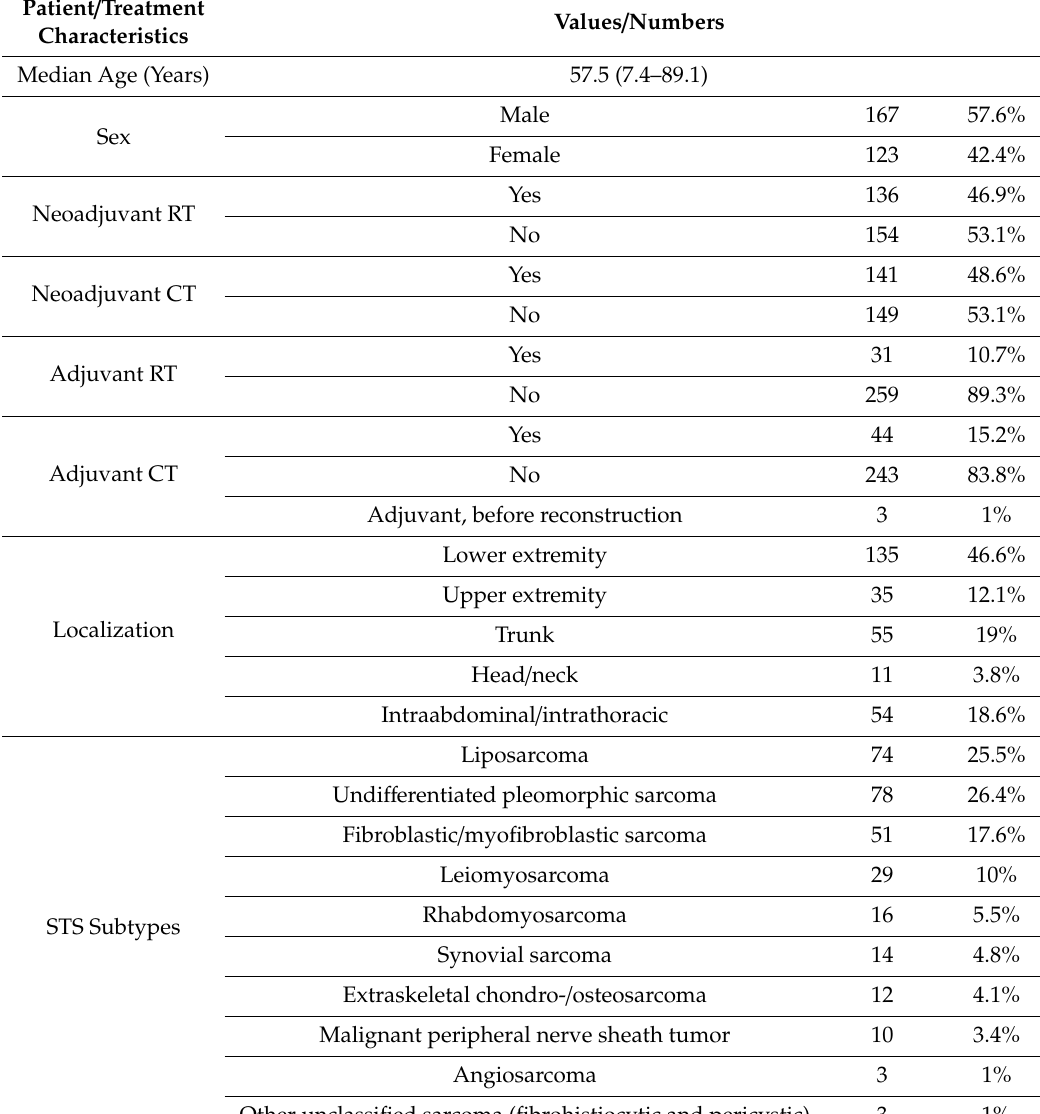
Table 1. Characteristics of the 290 included